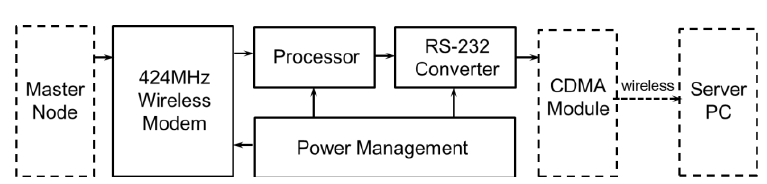
Figure 10. Master node diagram.